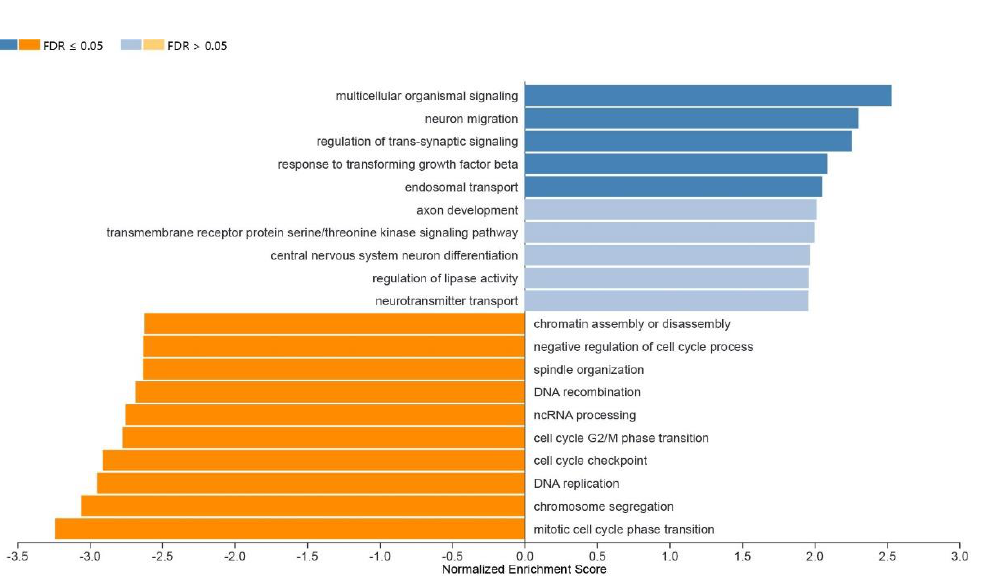
Figure 3 . Normalized enrichment scores of 10 of the most upregulated (blue) and downregulated (orange) GO terms.